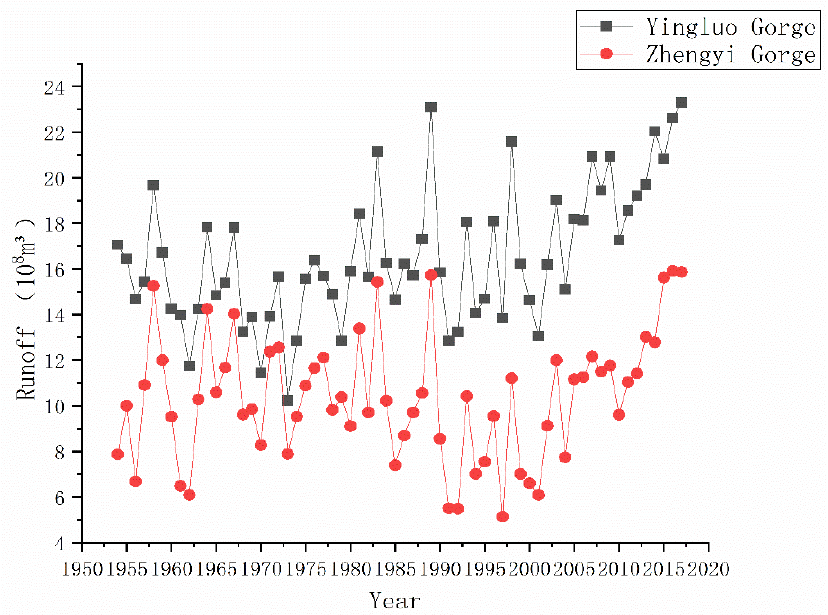
Figure 2. Interannual variation of runoff.